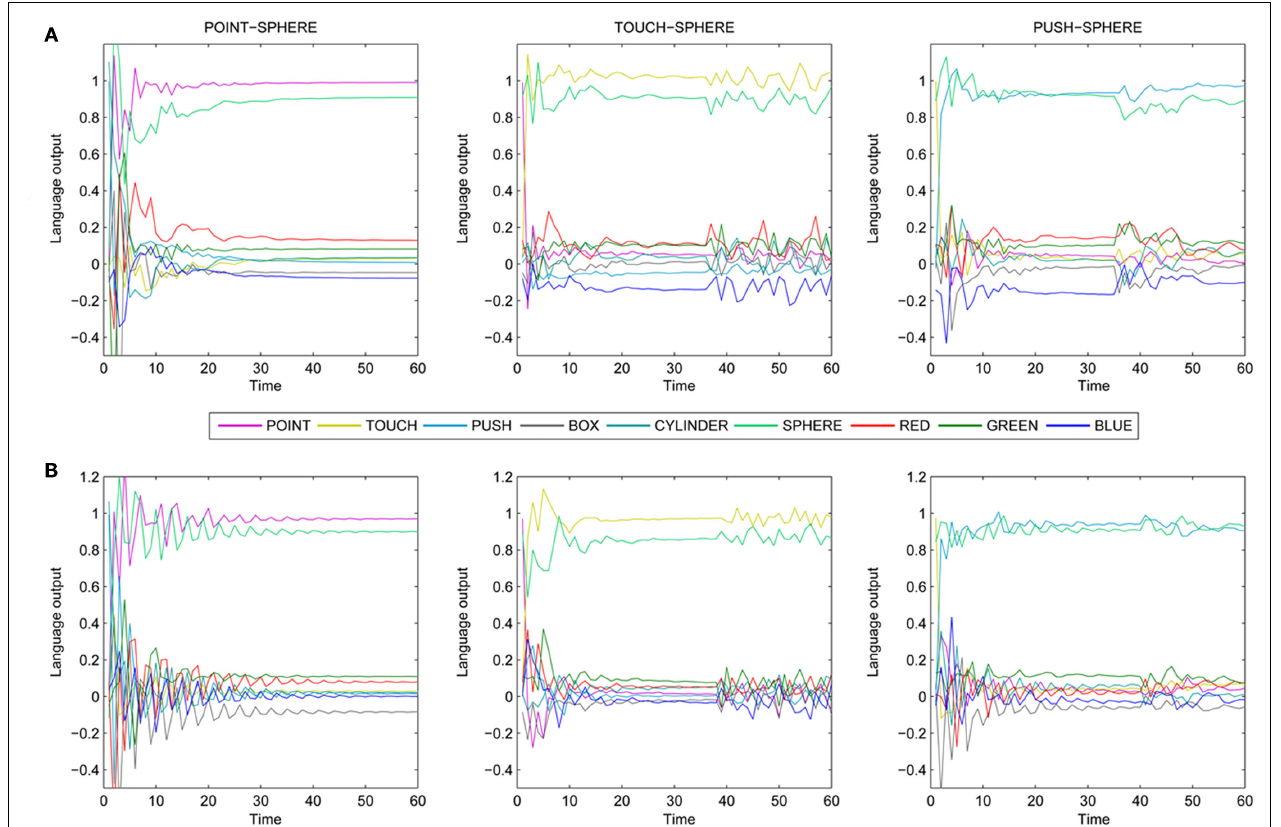
FIGURE 15 |The linguistic output ofAN module, during actions targeted at a sphere, as a function of discrete time steps (iterations). The actions start from ( A ) positions used during training, or ( B ) from random positions ( B ).